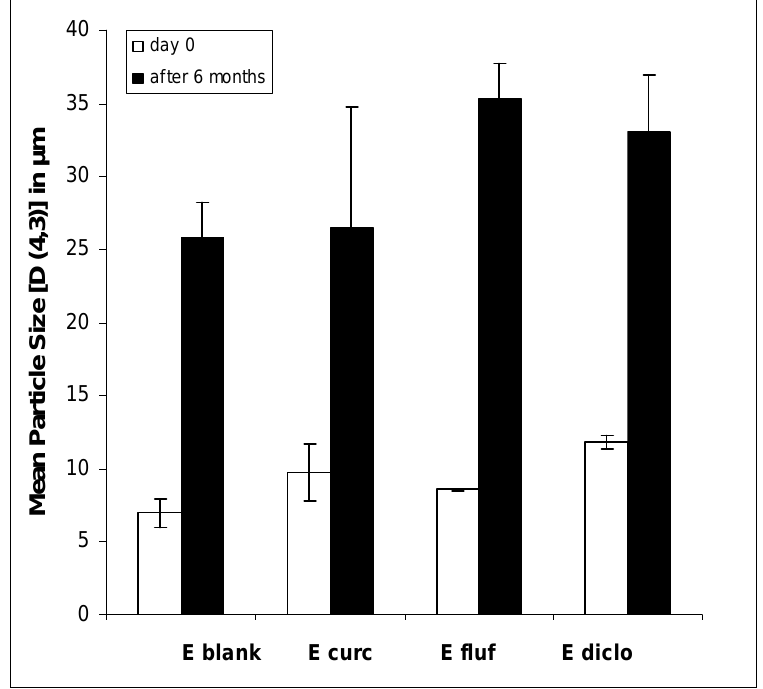
Figure 2. Mean droplet size of blank and drug-loaded macroemulsions (E, 2A ) and corresponding nanoemulsions (NE, 2B ) as determined immediately after production and after 6 months. The diluted samples were analyzed in triplicate at 25 °C on a Mastersizer 2000 (Malvern, UK) in case of the macroemulsions and a Zetasizer Nano ZS (Malvern, UK) in case of the nanoemulsions. The parameters shown are the volume weighted mean D [4,3] for macroemulsions and the mean droplet diameter as z-average for nanoemulsions. Values represent the mean of at least three formulations (n ≥ 3) and are given ±